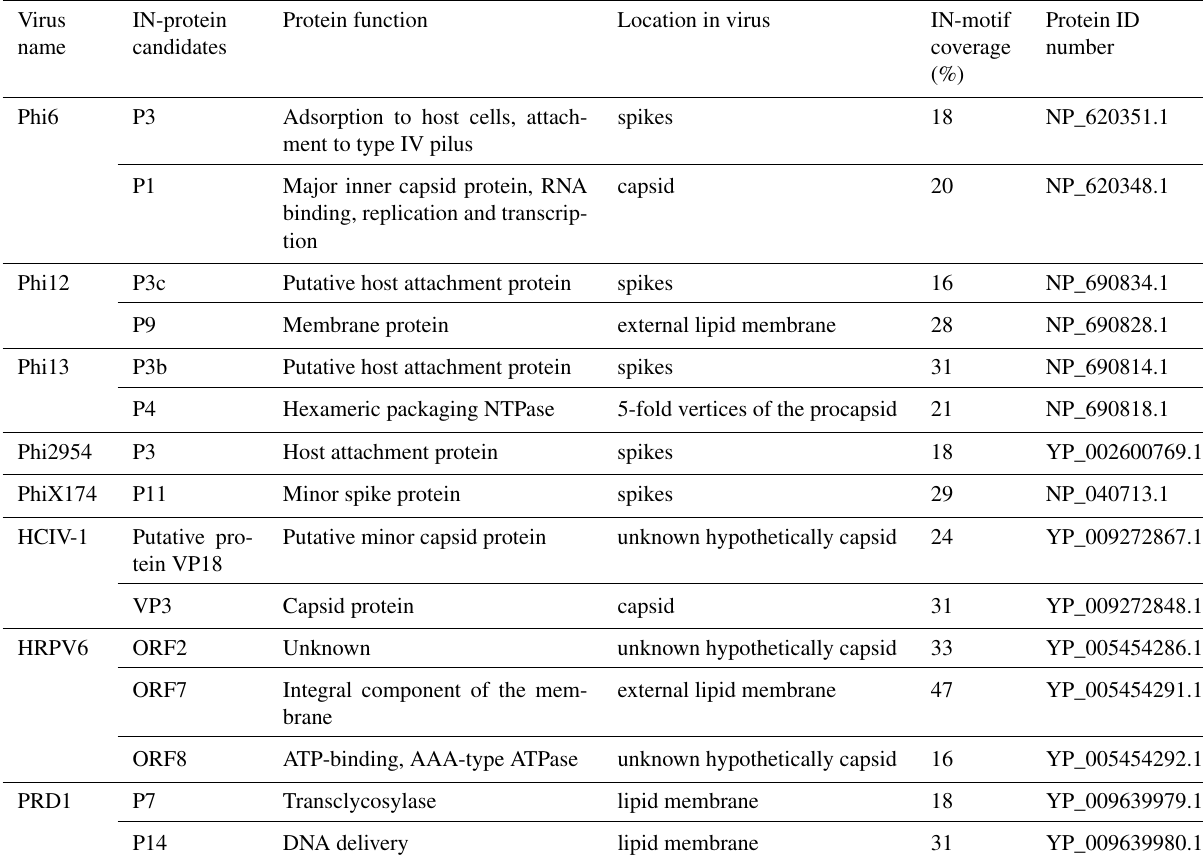
Table 1. Potential IN proteins, their location, function and INM coverage. Virus